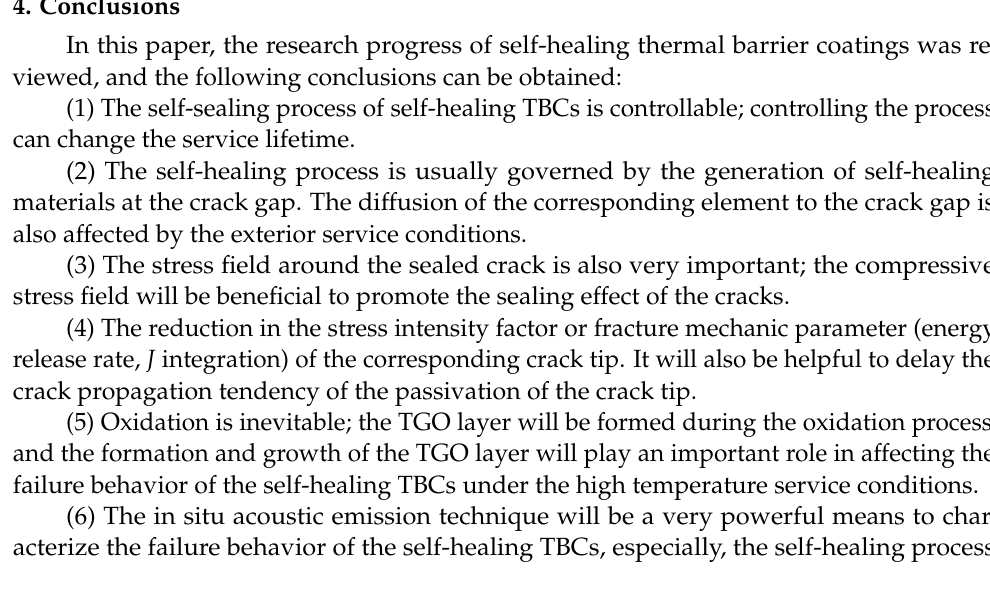
Figure 16. Acoustic emission method is used to study the failure caused by crack propagation and self-healing process of coatings. ( a ) Aero-engine profile; ( b ) thermal barrier coatings coated on the aero-engine guide vane prepared by atmospheric plasma spraying. ( i ) Acoustic emission signals caused by crack propagation; ( ii ) changes in acoustic emission signals caused by self-healing [85– 88].